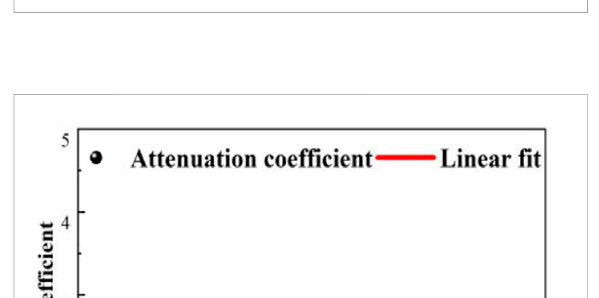
FIGURE 13 Fitting curve of V 1 value of coal sample in igneous intrusion zone.